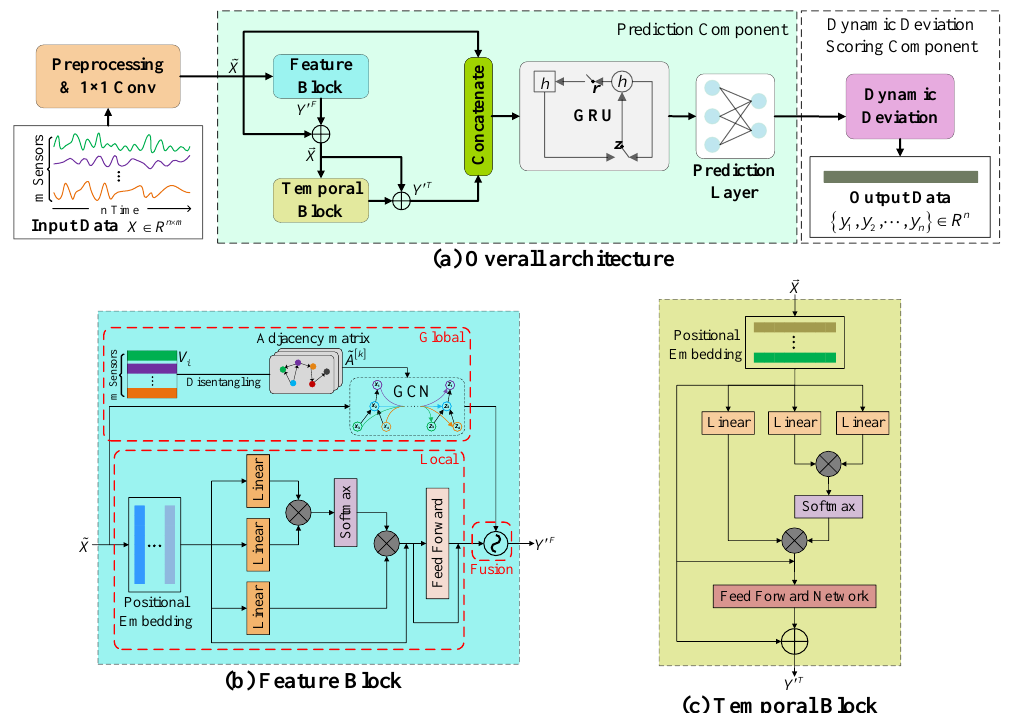
Figure 2. The proposed model architecture, which consists of a prediction module and a dynamic deviation module. The prediction module uses a feature block, temporal block, and GRU to jointly model the inter-sensor dependencies and time dependencies. Skip connections are used to combine all levels of